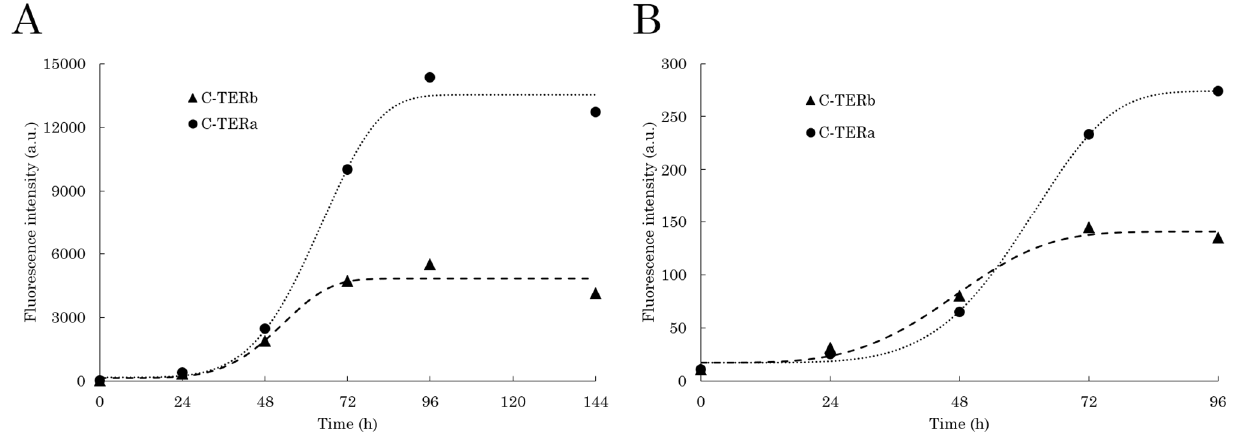
Figure 6 . Sigmoid ‐ fitted aggregation kinetic curves of C ‐ TERb (triangles, dashed line) and C ‐ TERa (circles, dotted line), using ( A ) dbAF emission at 456 nm ( λ ex = 400 nm, sw = 10 nm) and ( B ) ThT fluorescence at 485 nm ( λ ex = 440 nm, sw = 10 nm, C ThT = 10 μ M). Samples were incubated in TBS at ~20 °C for 96 to 144 h (C C ‐ TER = 10 μ M).